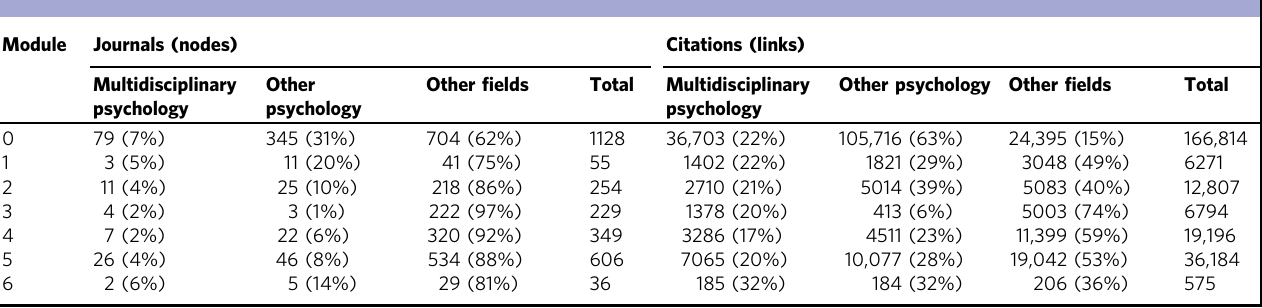
Table 3 Summary statistics for each module in the 2018 citation network.